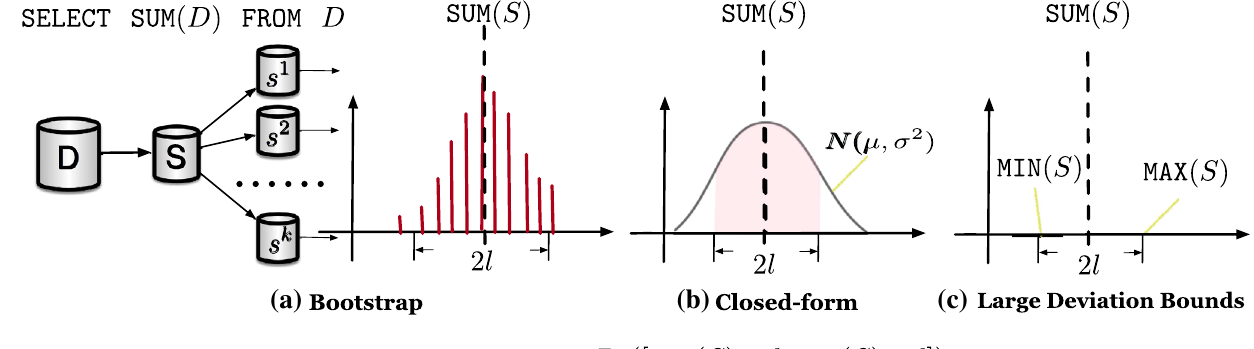
Fig. 4 Example of Error